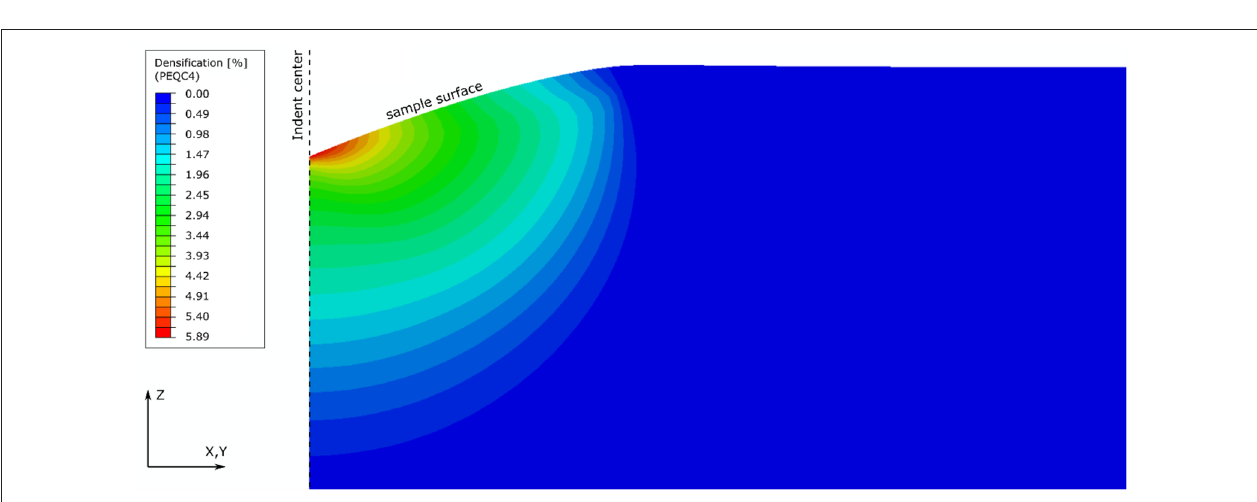
FIGURE 10 | Compositional dependence of (A,B) crack resistance, (C,D) indentation-induced (981 mN) shift in the low frequency Raman center of gravity (COG) and (E,F) strain-rate sensitivity (m): (A,C,E) increasing P 2 O 5 content and constant 60 mol% SiO 2 , (B,D,F) increasing SiO 2 content and constant P 2 O 5 contents of 0 (black squares) or 7.5 mol% (orange circles). Only for (C,D) : Filled symbols show COG shift after data reduction by the Long equation, preceded by a baseline correction at the high frequency end of the spectra. Open symbols show COG shift after subtraction of a linear baseline from the low frequency spectral region.